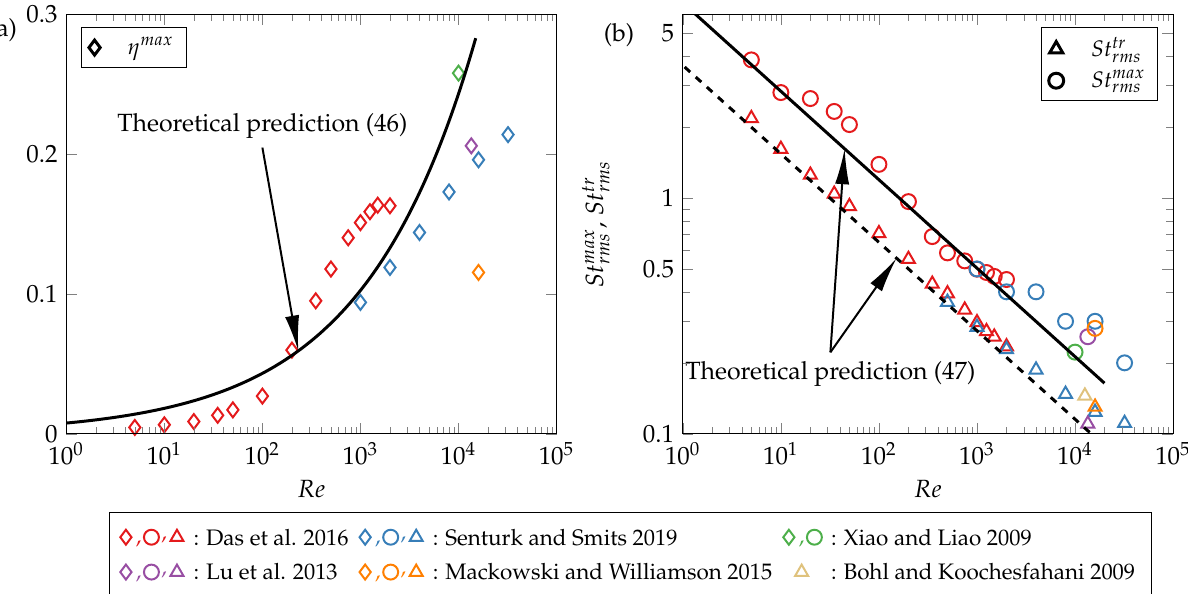
Figure 5. Maximum propulsive efficiency η max (panel ( a )) and, the corresponding Strouhal number St max rms at which maximum efficiency is achieved and the drag-to-thrust transition Strouhal number St tr rms (panel ( b )) as a function of Re . Discrete points are taken from the previous experimental and computational investigations as indicated in the legend above. The symbols ( ), ( ) and ( ) represent η max , St max rms and St tr rms , respectively, with the colors used to distinguish the discrete dataset from each of the prior experimental and computational investigations. Multiple similarly colored and shaped symbols are used to represent discrete dataset corresponding to a similar Re but distinct θ 0 . Bohl and Koochesfahani [37] focus on drag-to-thrust transition and their reported dataset does not include mean thrust or efficiency. Xiao and Liao [41] target thrust maximization and the Strouhal number range investigated in their computational work is beyond the Strouhal number St tr rms for the drag-to-thrust transition. The solid line in the left panel ( a ) represents the theoretical prediction (46). The solid and dashed lines in the right panel ( b ) are obtained from the theoretical predictions (47). Note that theoretical predictions are expected to hold only over a limited Re range for which the boundary layer remains laminar and therefore, the solid and the dashed lines extend only upto a finite Re